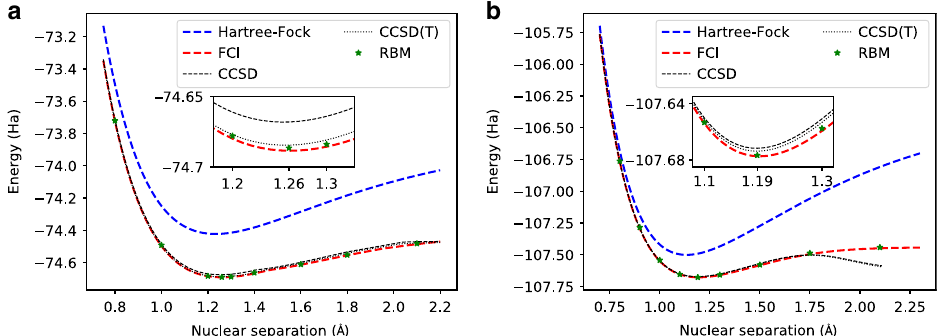
Fig. 1 Dissociation pro fi les. The accuracy of fermionic neural-network quantum states compared with other quantum chemistry approaches. Shown here are dissociation curves for a C 2 and b N 2 , in the STO-3G basis with 20 spin-orbitals. The RBM used has 40 hidden units, and it is compared to both coupled-cluster approaches (CCSD, CCSD(T)) and FCI